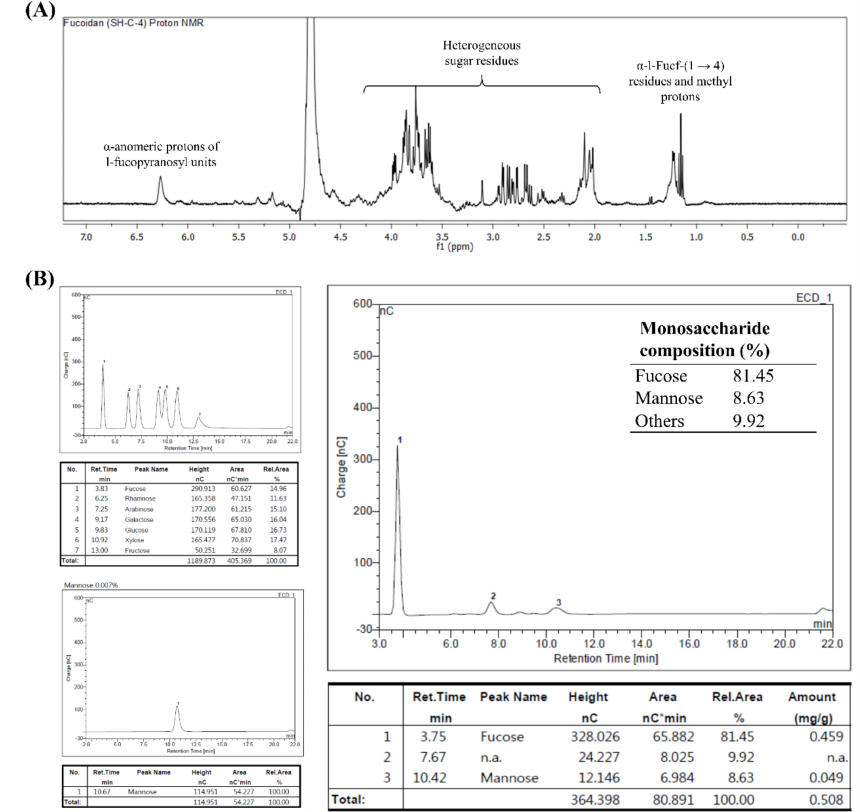
Figure 4. Characterization of fraction SHC4 by nuclear magnetic resonance (NMR) and monosaccharide composition analysis. SHC4 ( A ) 1 H NMR spectrum and ( B ) monosaccharide composition